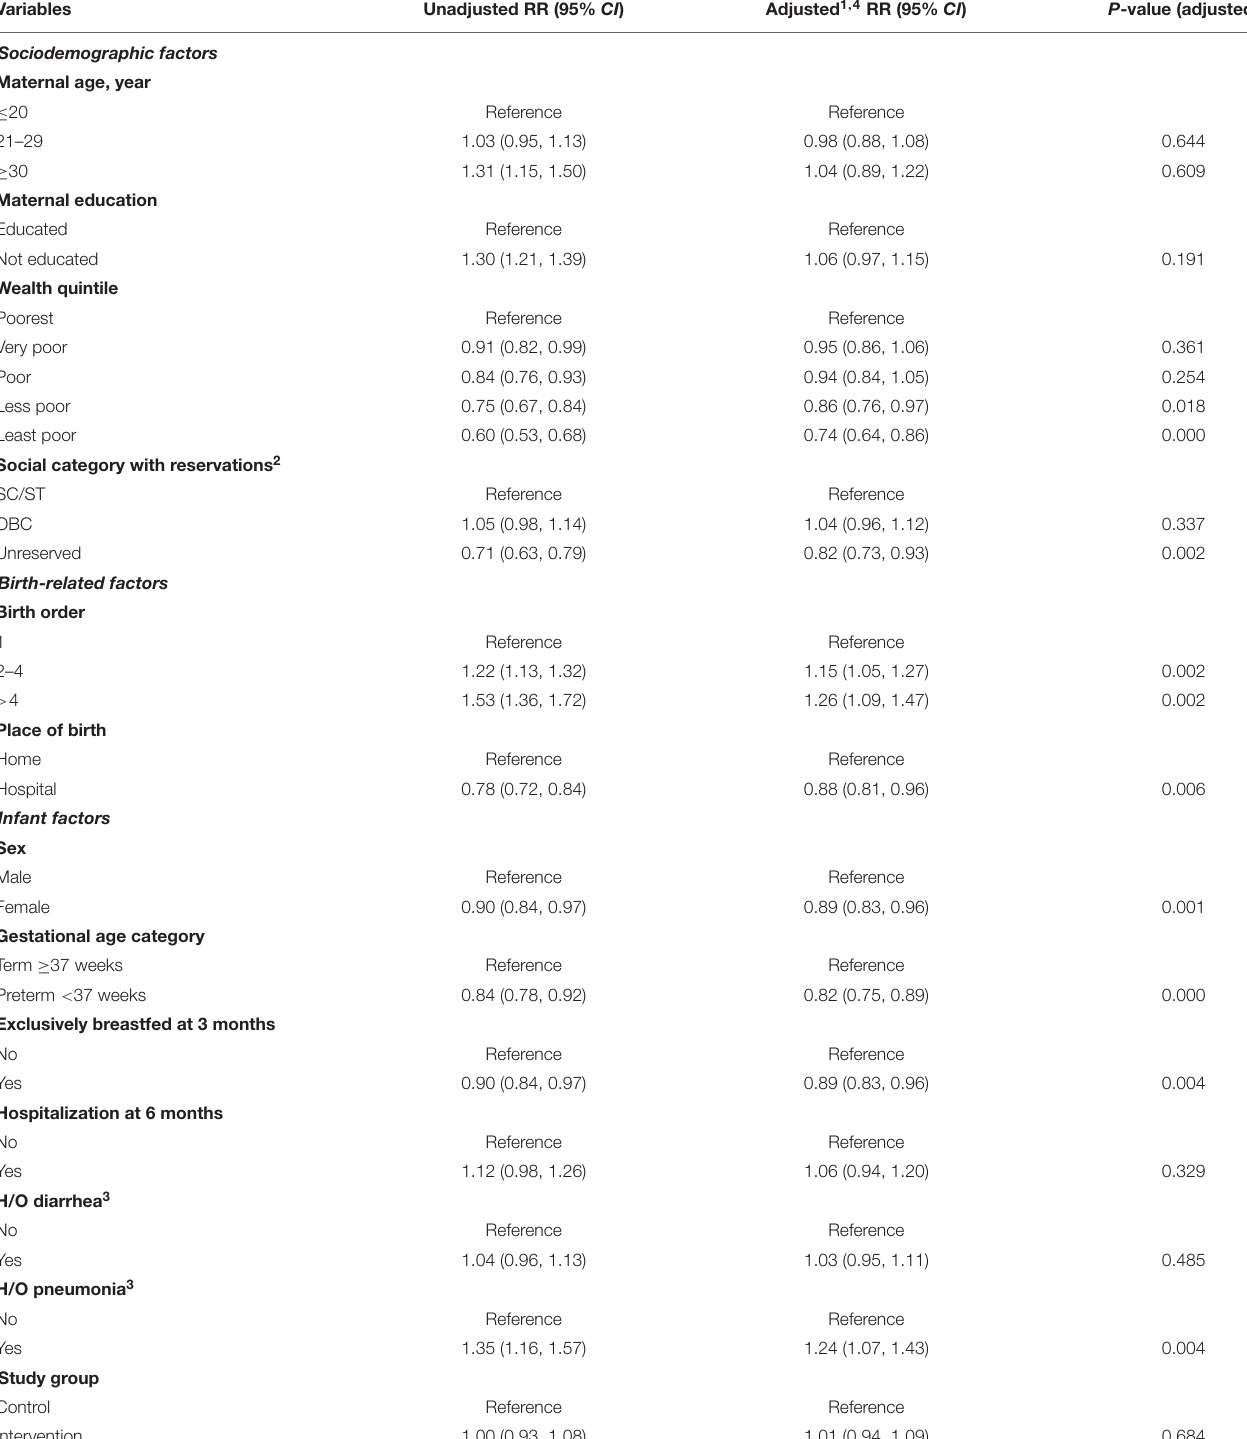
TABLE 2 | Factors associated with poor catch-up in linear growth status at 6 months among low birthweight small-for-gestational-age (SGA-LBW)